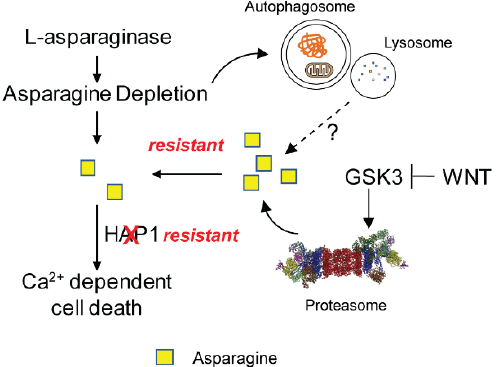
Figure 2. Mechanisms driving L-asparaginase resistance independently of ASNS. Potential contribution of proteolytic/autophagic scavenging of asparagine and Ca 2+ -dependent cell death inhibition to L-asparaginase resistance.